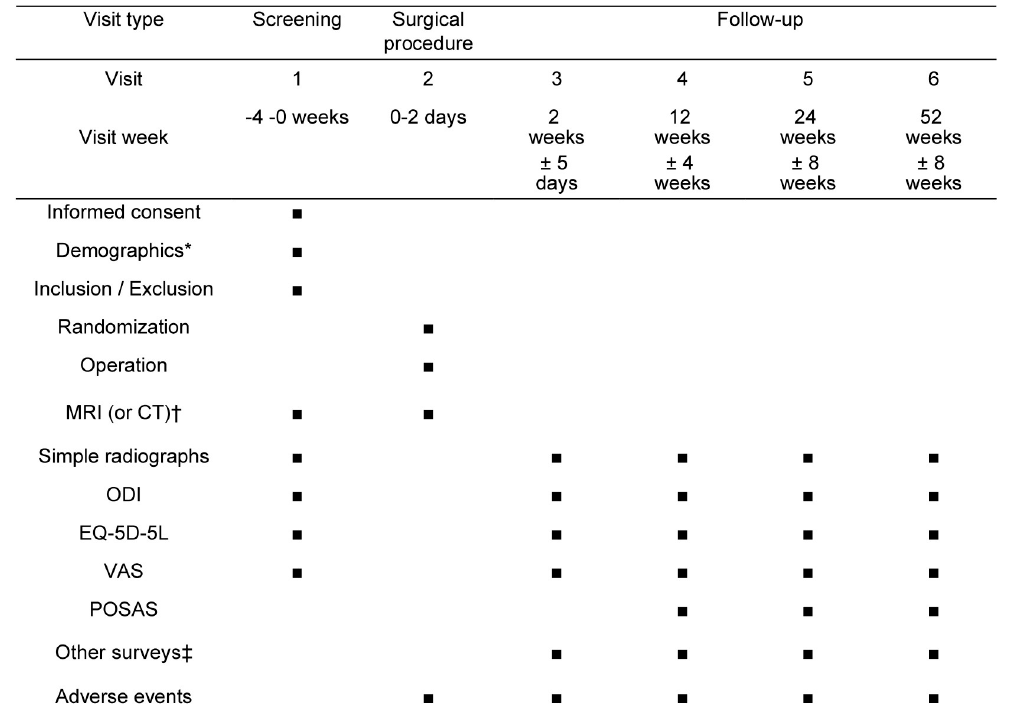
Fig 1. Schedule of enrollment, interventions, and assessments. Abbreviations: MRI, magnetic resonance imaging; CT, computed tomography; ODI, Oswestry Disability Index; EQ-5D-5L, EuroQol 5 Dimension 5 level; VAS, visual analog scale; POSAS, Patient and Observer Scar Assessment Scale. * Baseline patient characteristics, including data about past medical/ surgical history, physical examination, and laboratory tests. † CT will be performed when MRI cannot be performed. ‡ including satisfaction with the surgery, walking distance/time, and time required to return to daily activities postoperatively.